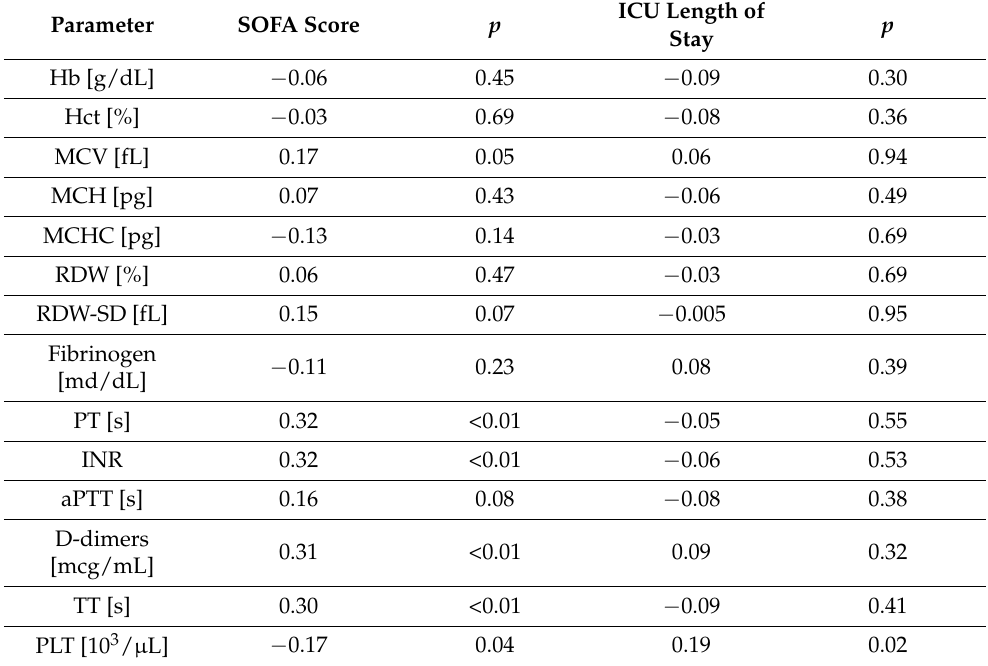
Table 5. Associations between analyzed parameters, sepsis severity and intensive care unit length of